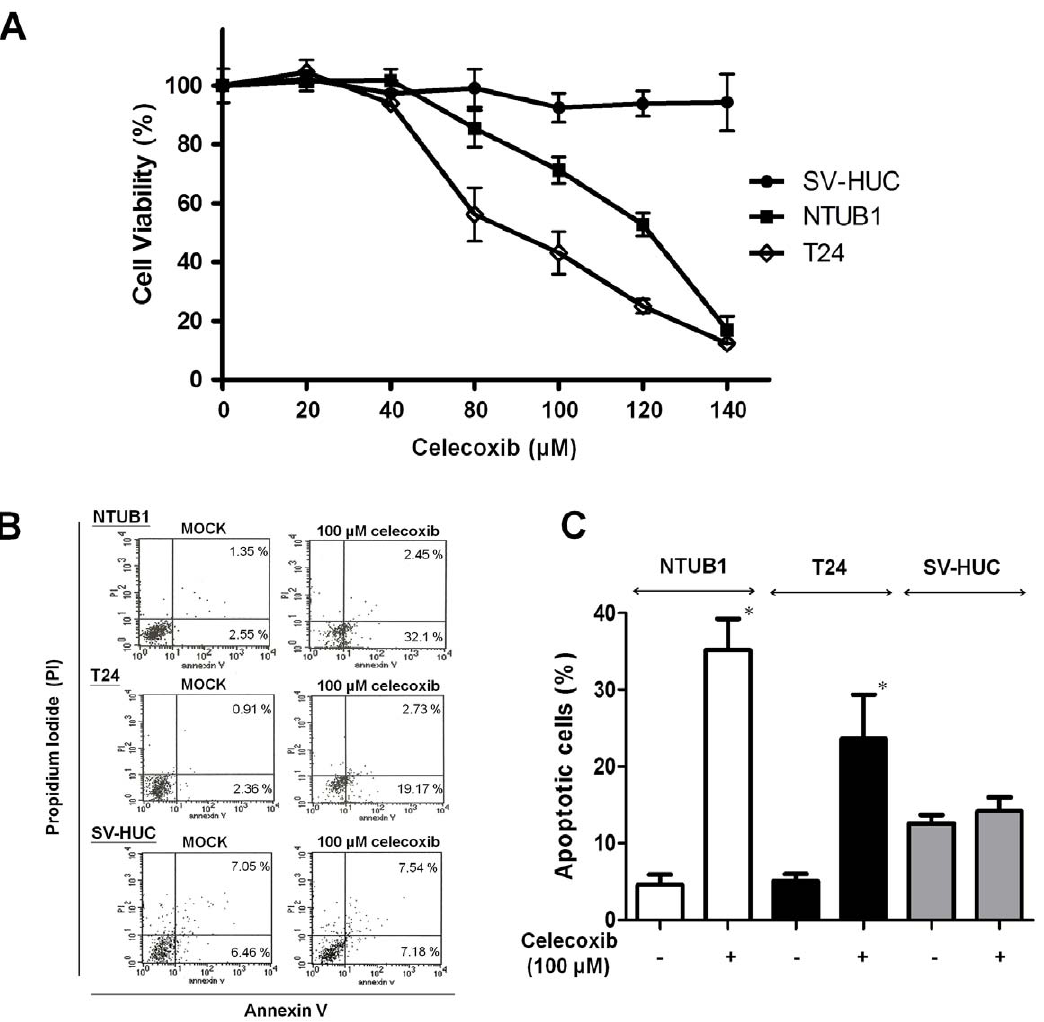
Figure 1. Celecoxib reduces cell viability and induces apoptosis in UC cells and SV-HUC cells. (A) Cells were treated with various concentrations of celecoxib for 24 h. Cell viability was assessed by MTT assay. (B) Cells were exposed to mock (untreated) and 100 m M celecoxib for 24 h. Apoptotic cells were analyzed by FACS flow cytometry with propidium iodide (PI) and annexin V-FITC staining. The lower-right panel presented annexin V-positive cells (early apoptotic cells); the upper-right panel presented late apoptotic cells with membranes permeable to PI and annexin